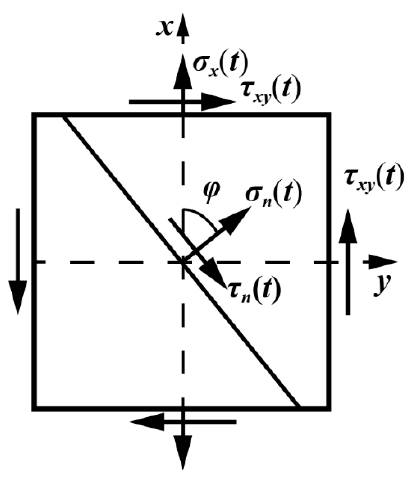
Figure 4. Stress state and plane direction under multiaxial fatigue loading.